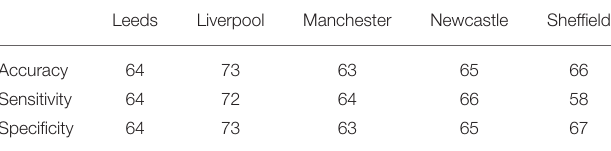
TABLE 7 | By-city classification accuracy based on top two features